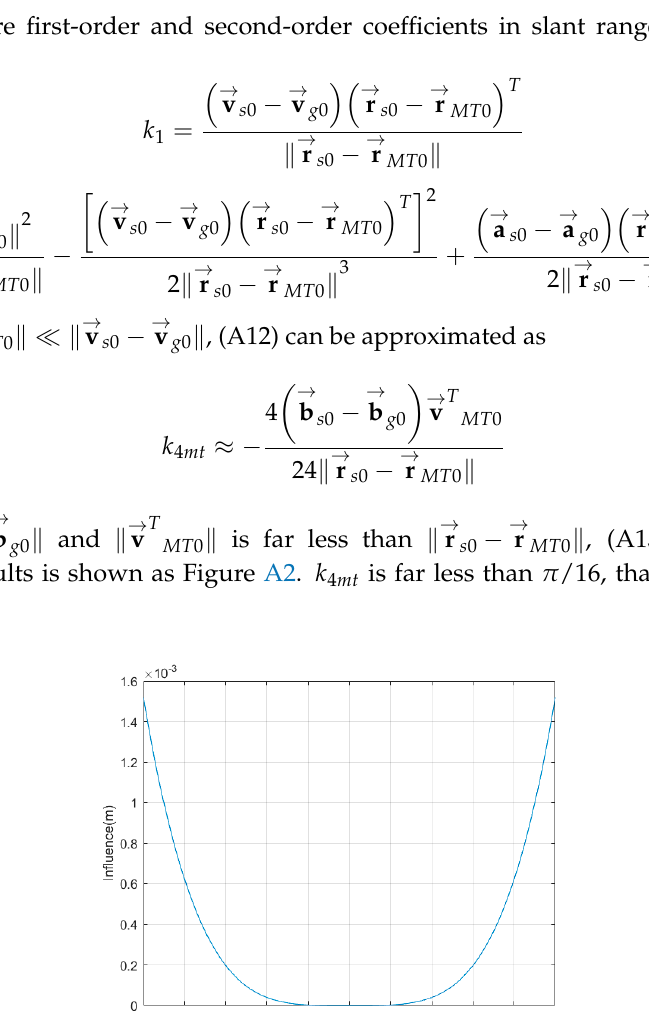
Figure A2. The influence of target motion on